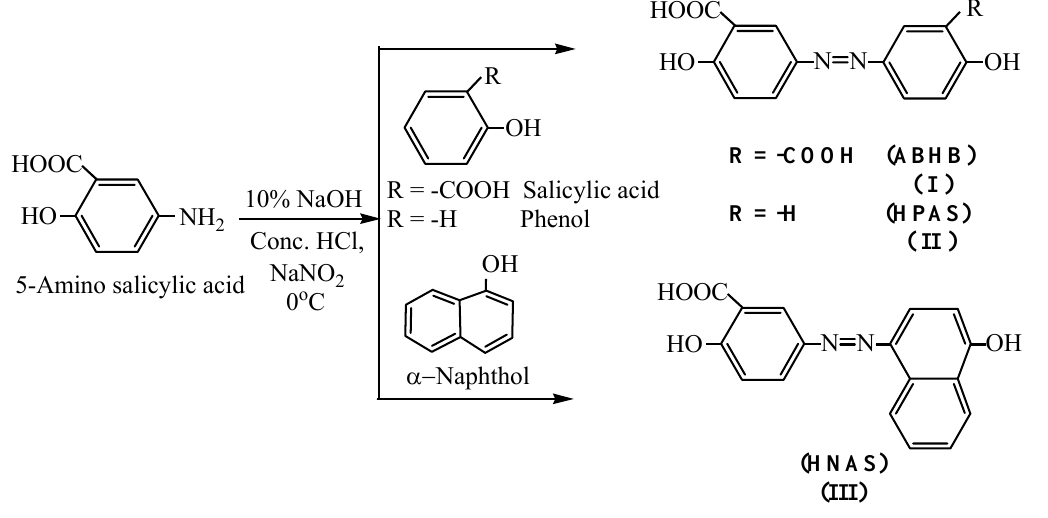
Table 1. Elemental microanalysis of dihydroxyazobenzene derivatives based on 5- aminosalicylic acid I – III and their polymers IV – VI . Product